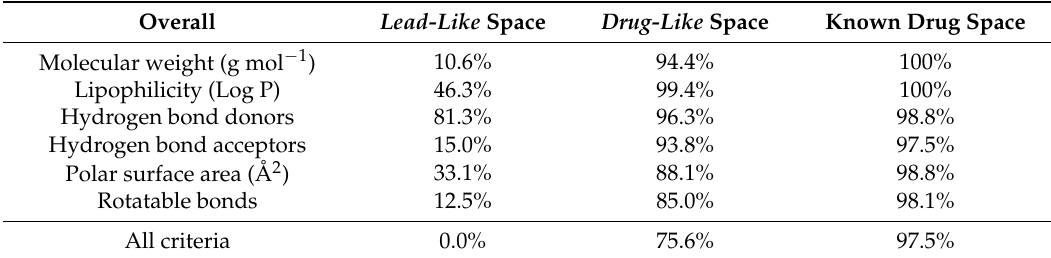
Table 3. All compounds in this study and their inclusion within the defined chemical